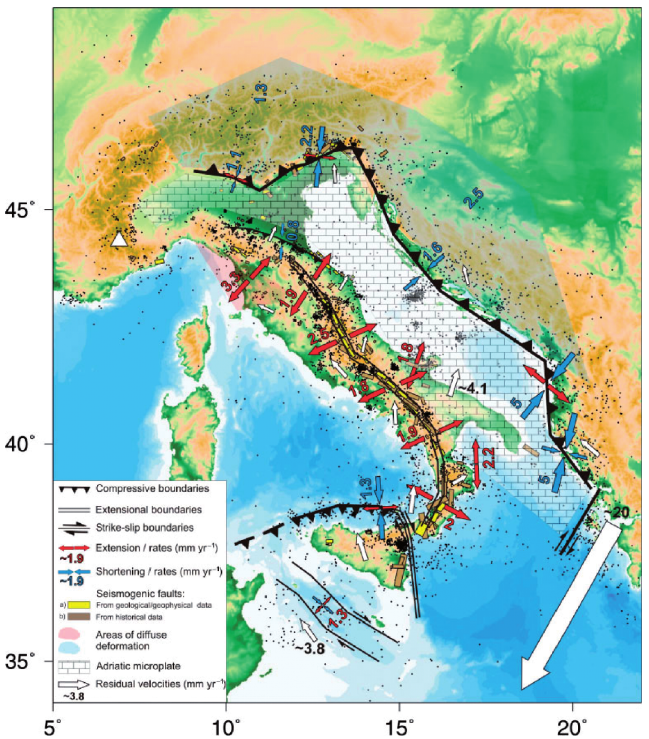
Fig. 7. Current geodetic strain field of the Italian region from GPS and CGPS data (from Serpelloni et al. ,